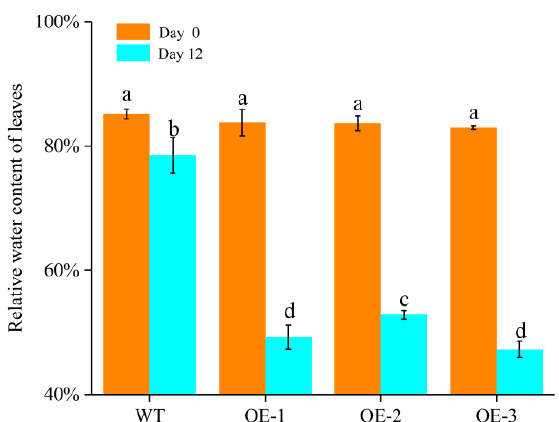
Figure 5. Natural drought treatment of stu-miR398b-3p overexpression lines. ( A ) On day 0, there was no significant difference in the normal growth status of potato WT lines and OE lines. ( B ) On the 12th day, potato WT and OE plants showed phenotypic differences. The color of the leaves of the WT plants was bright, and the color of the leaves of the OE plants was dim. The leaves of WT plants were firm, and the leaves of OE plants were wilting. ( C ) On the 21th day, the hue is gloomy, the leaves are fragile and drooping, and WT plants are dying. Plants of OE were died, and their leaves turned yellow and dried out. Three independent biological samples with three technical replicates were used for drought resistance analysis. A total of 36 pots of potato plants were planted, including 9 pots of WT lines and 9 pots of each OE line. And all plant phenotypic changes are consistent with the above.